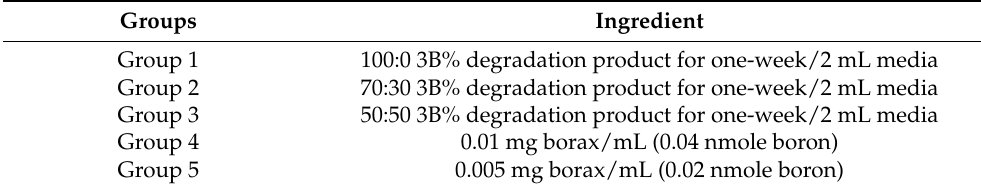
Table 3. Media contents of scratch assay for MG63 cells.